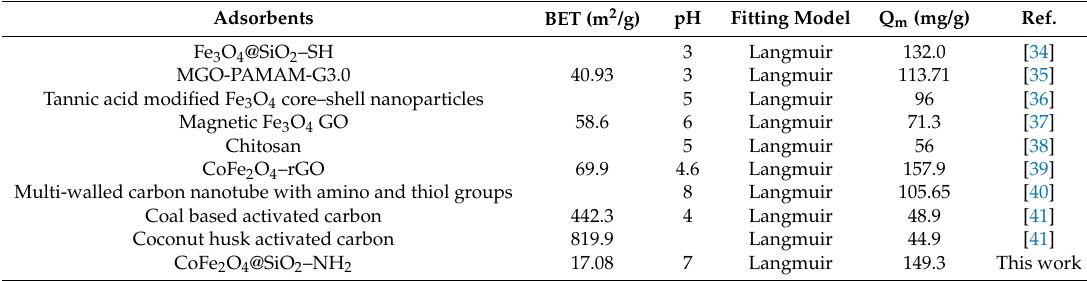
Table 4. Comparison of adsorption capacity for adsorbed Hg(II) with different adsorbents.